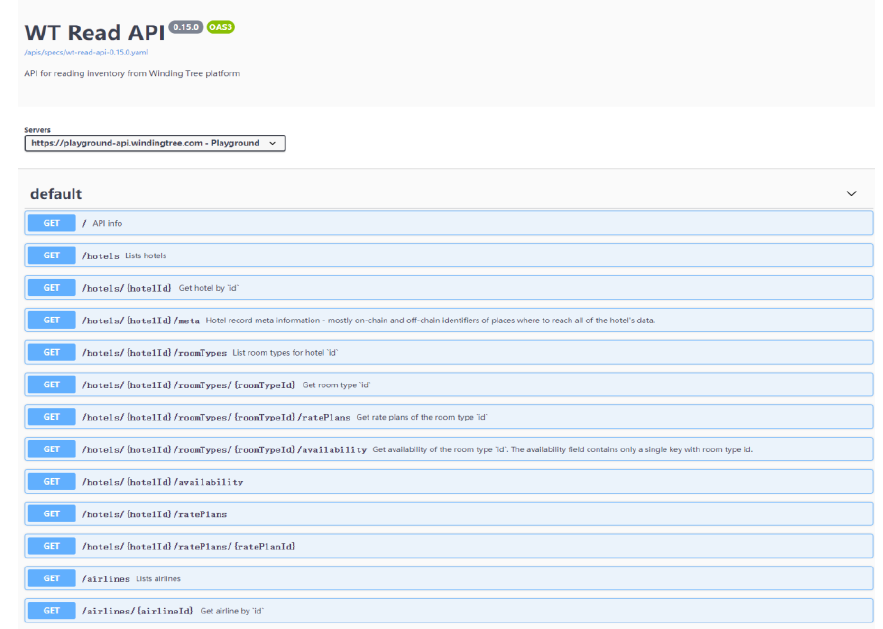
Figure 20. Screenshot of ReadAPI.